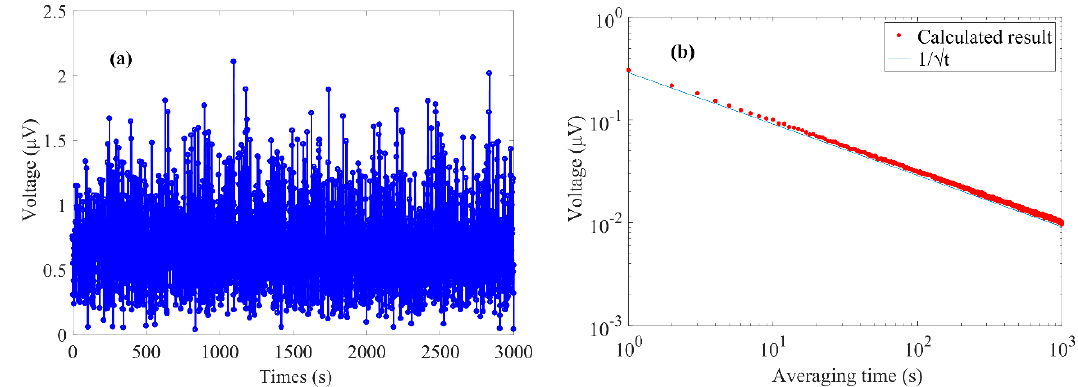
Figure 8. ( a ) PA signal with a 1-s lock-in integral time when the chamber was filled with ambient air. ( b ) Allan–Werle deviation analysis result.